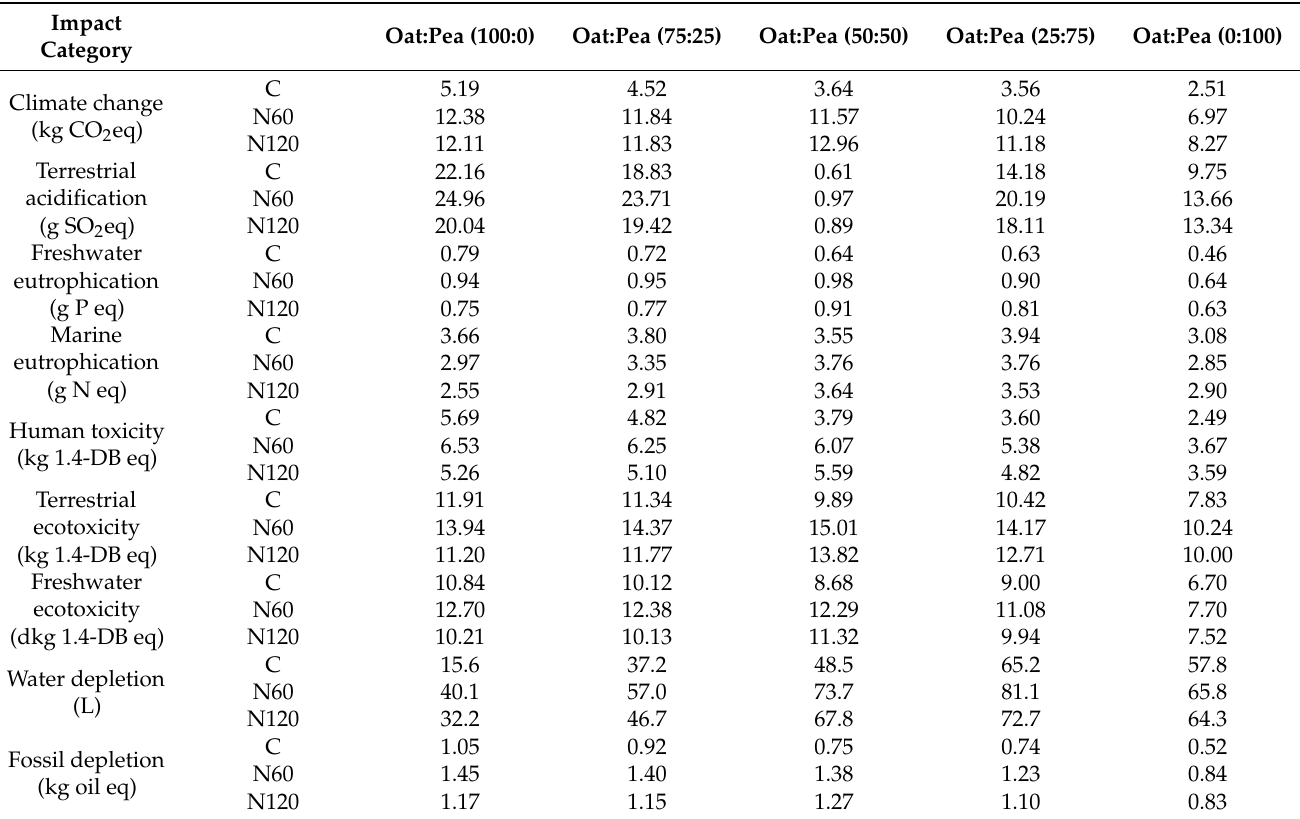
Table 2. Environmental Impact per 1 kg of grain N Yield ha − 1 .